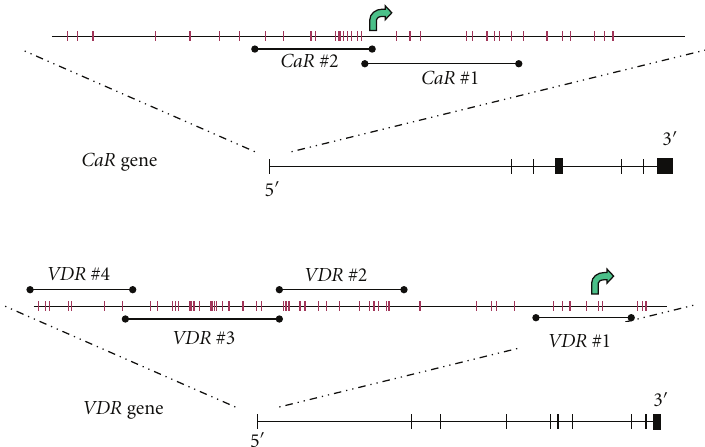
Figure 2: Outline of CpG islands in CaR and VDR promoters. The solid horizontal lines labeled CaR#1-2 and VDR#1-4 indicate the locations of the PCR products, and the arrow indicates the exon 1 start. The small vertical lines in the promoter regions indicate individual CpG